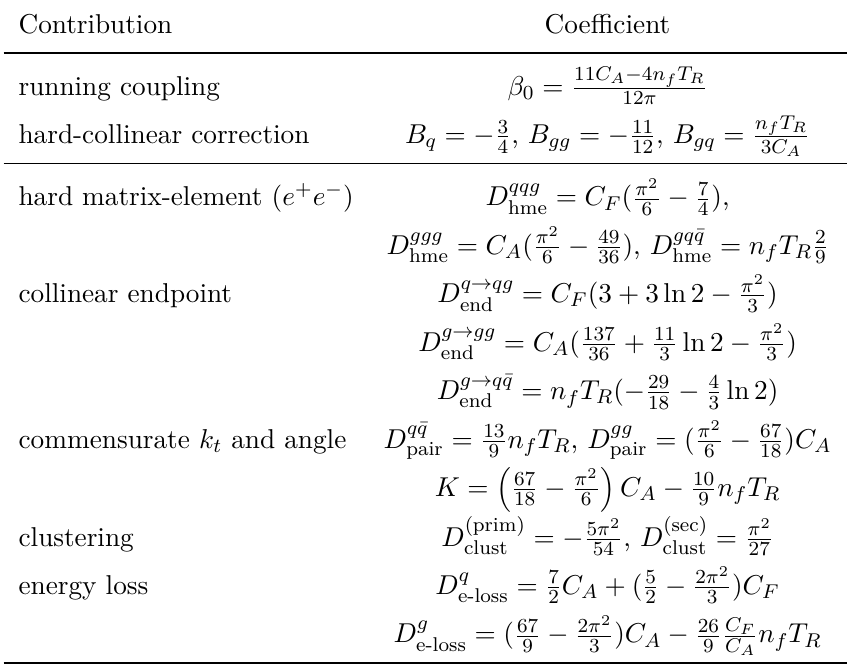
functions (bottom 3 ,e + e −